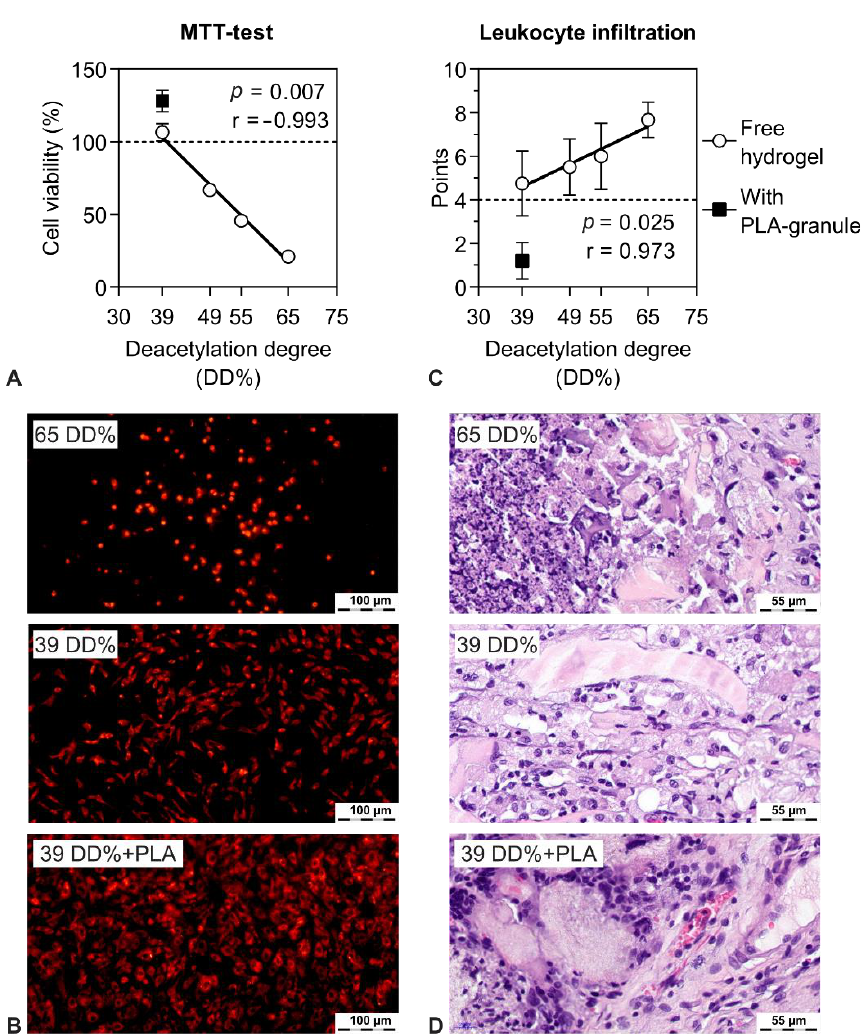
Figure 1. The effect of chitosan reacetylation on the biocompatibility of the thermosetting chitosan – β-glycerophosphate hydrogel. ( A ) MSC viability in the presence of chitosan hydrogels, seven days, MTT test. ( B ) Cell adhesion of the chitosan-based hydrogels at the lowest and highest degrees of deacetylation (65 and 39 DD%), PKH26 staining. ( C ) Level of leukocyte infiltration 14 days after subcutaneous implantation of chitosan hydrogels. ( D ) Tissue sections of the implantation area of the chitosan-based hydrogels with high and low degrees of deacetylation (65 and 39 DD%).